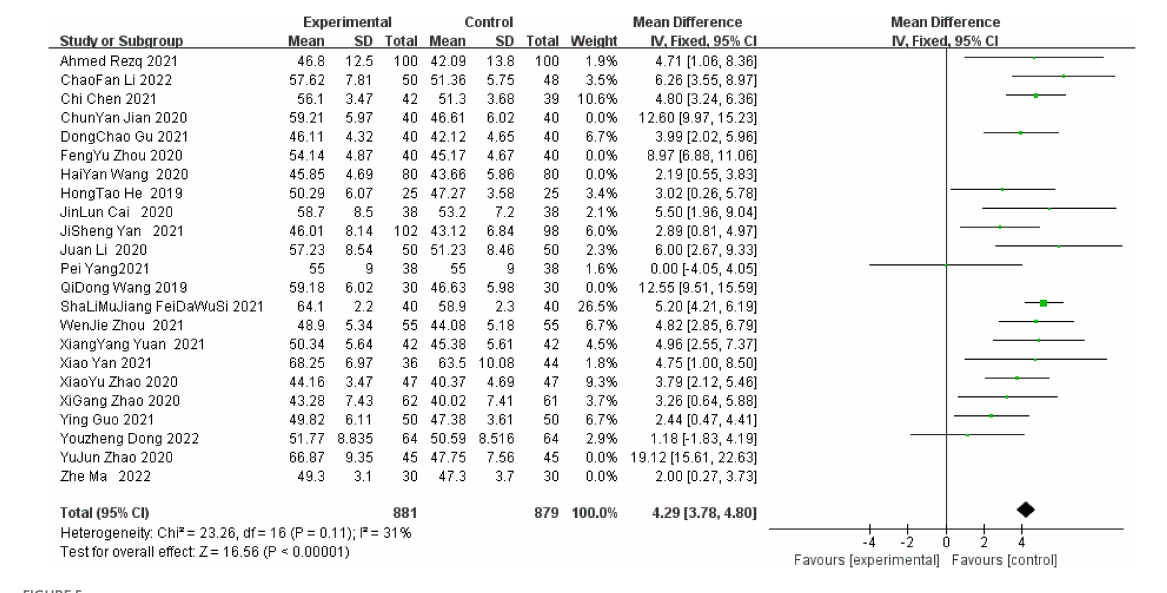
FIGURE5 Left ventricular ejection fraction (LVEF) within 6 months after surgery.